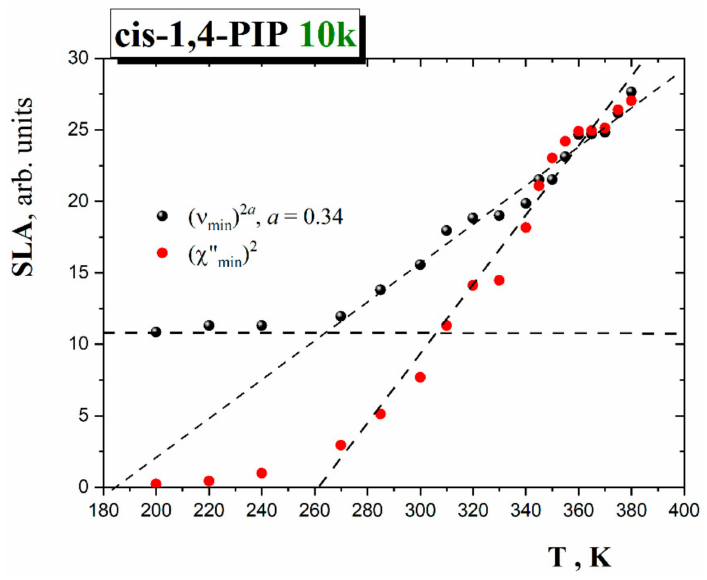
Figure 10. Scaled law amplitude (SLA) as a function of temperature for cis